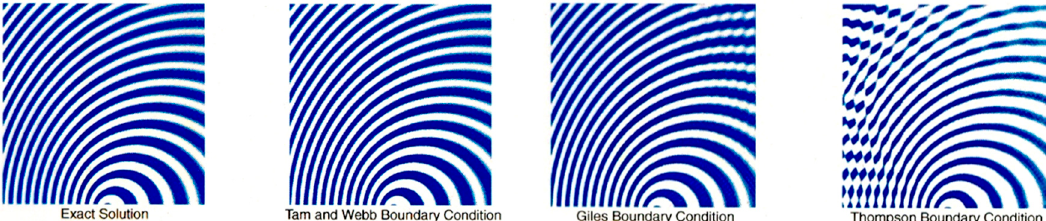
Figure 10. Effect of implementing various boundary treatments on the calculated acoustic field associate with an acoustic monopole in a uniform flow (Ref. [49]).